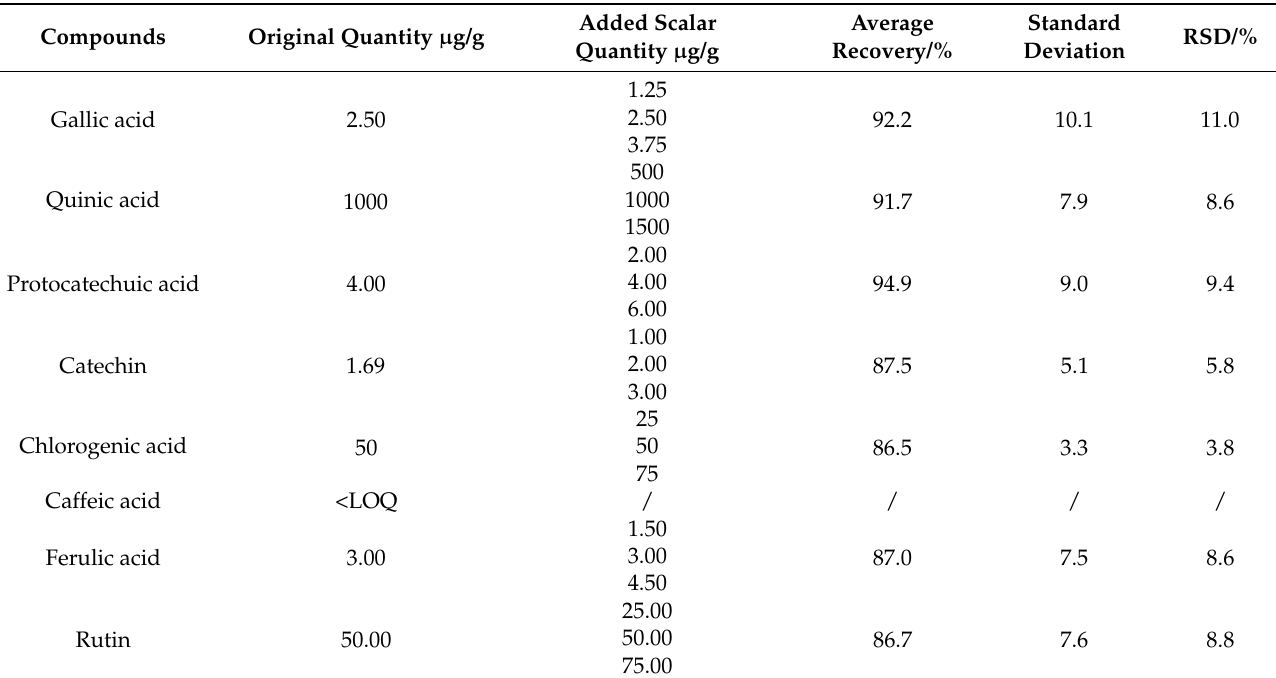
Table 4. Recovery of phenolic compounds in the peel of 10 banana cultivars ( n = 6).